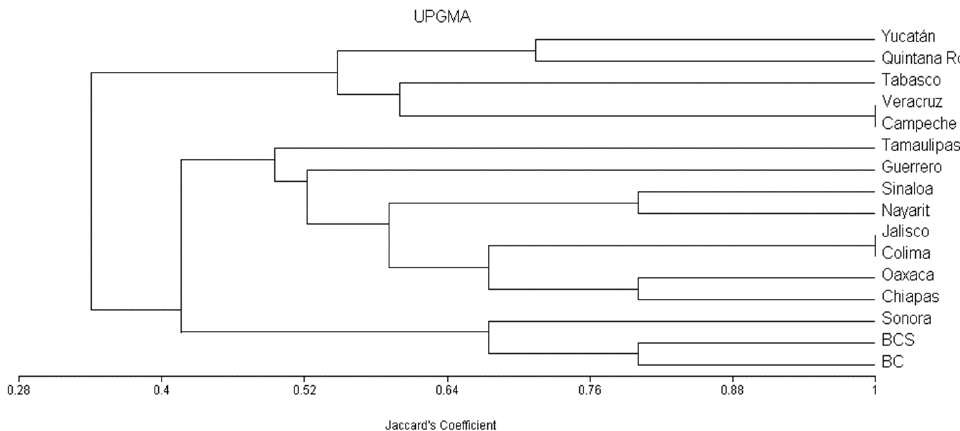
Figure 8. Cluster analysis in which the coastal states of Mexico are grouped according to the number of invasive plant species and frequency of of invasive plant species and frequency of observations.